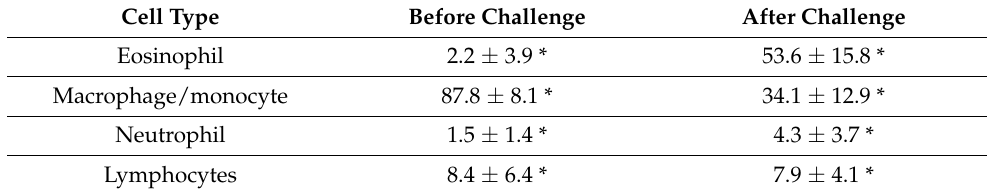
Table A2. Cell % change 48 h after